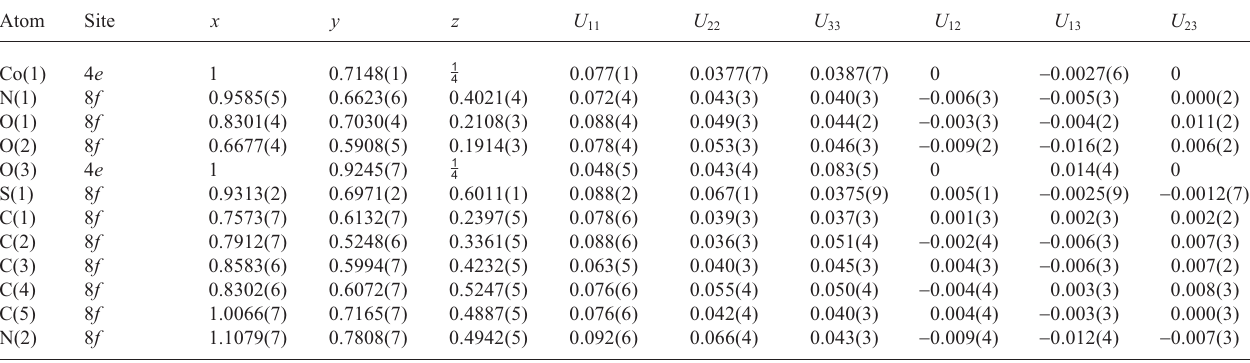
Table 3. Atomic coordinates and displacement parameters (in Å 2 )